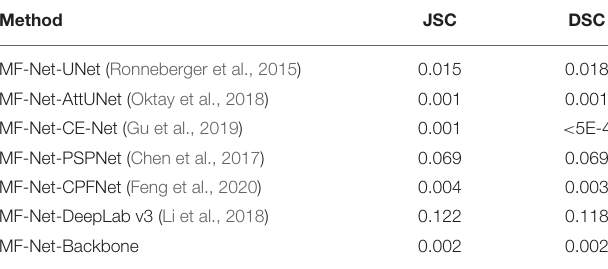
TABLE 3 | Statistical analysis ( p -value) of the proposed MF-Net compared with other CNN-based methods.